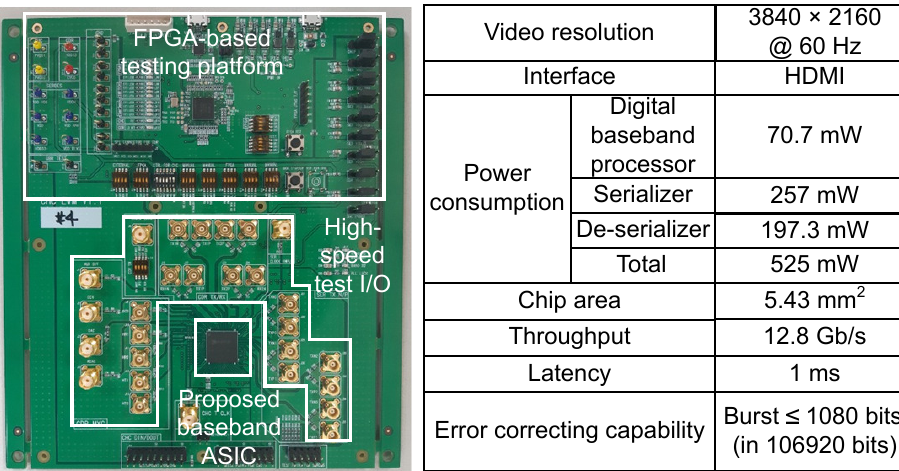
Figure 11. A FPGA-based testing platform with high-speed interface